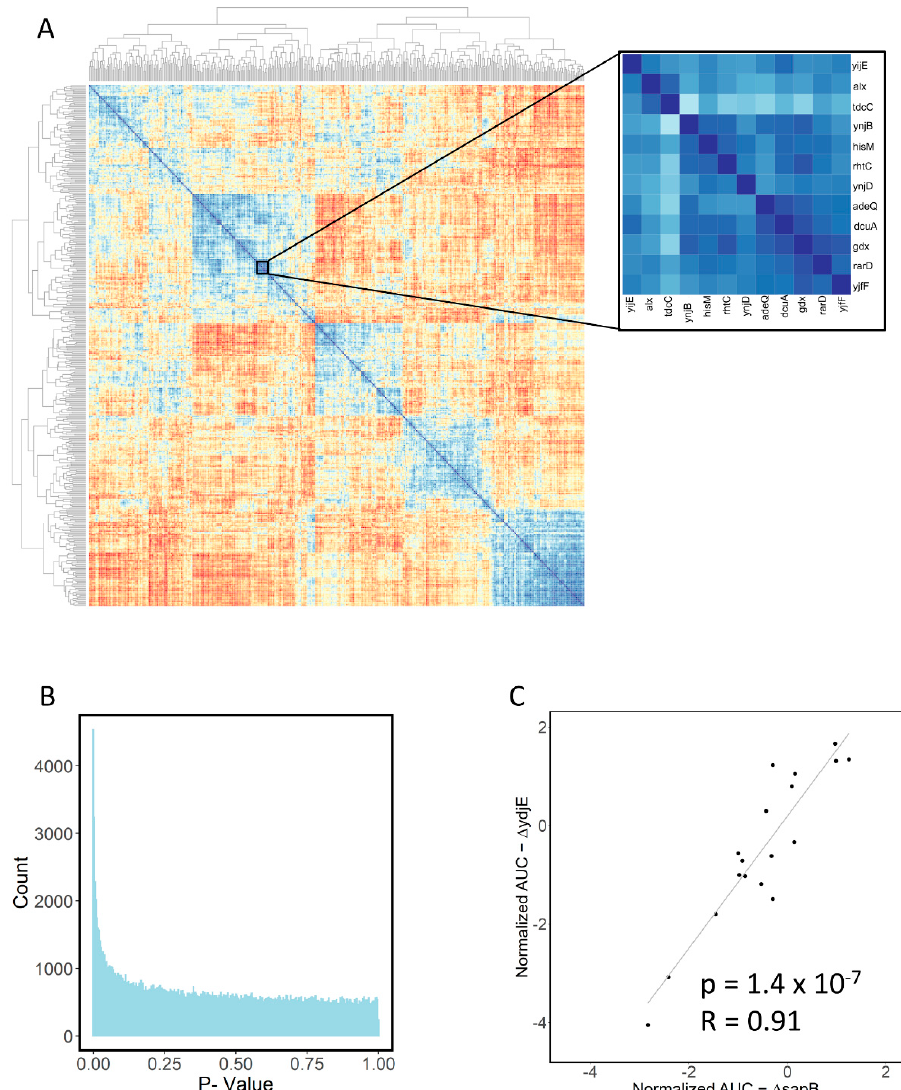
Figure 8. ( A ). Heatmap showing correlations between area under the curve values for transporters in all antibiotics. Zoom inset highlights a cluster of highly correlated transporter knockout strains. ( B ) Histogram of p -values for all correlations showing the peak around 0, indicating likely true positive results. ( C ) Scatter plot indicating high degree of correlation between ∆ sapB and ∆ ydjE . Table 5. Transporters that are highly correlated.